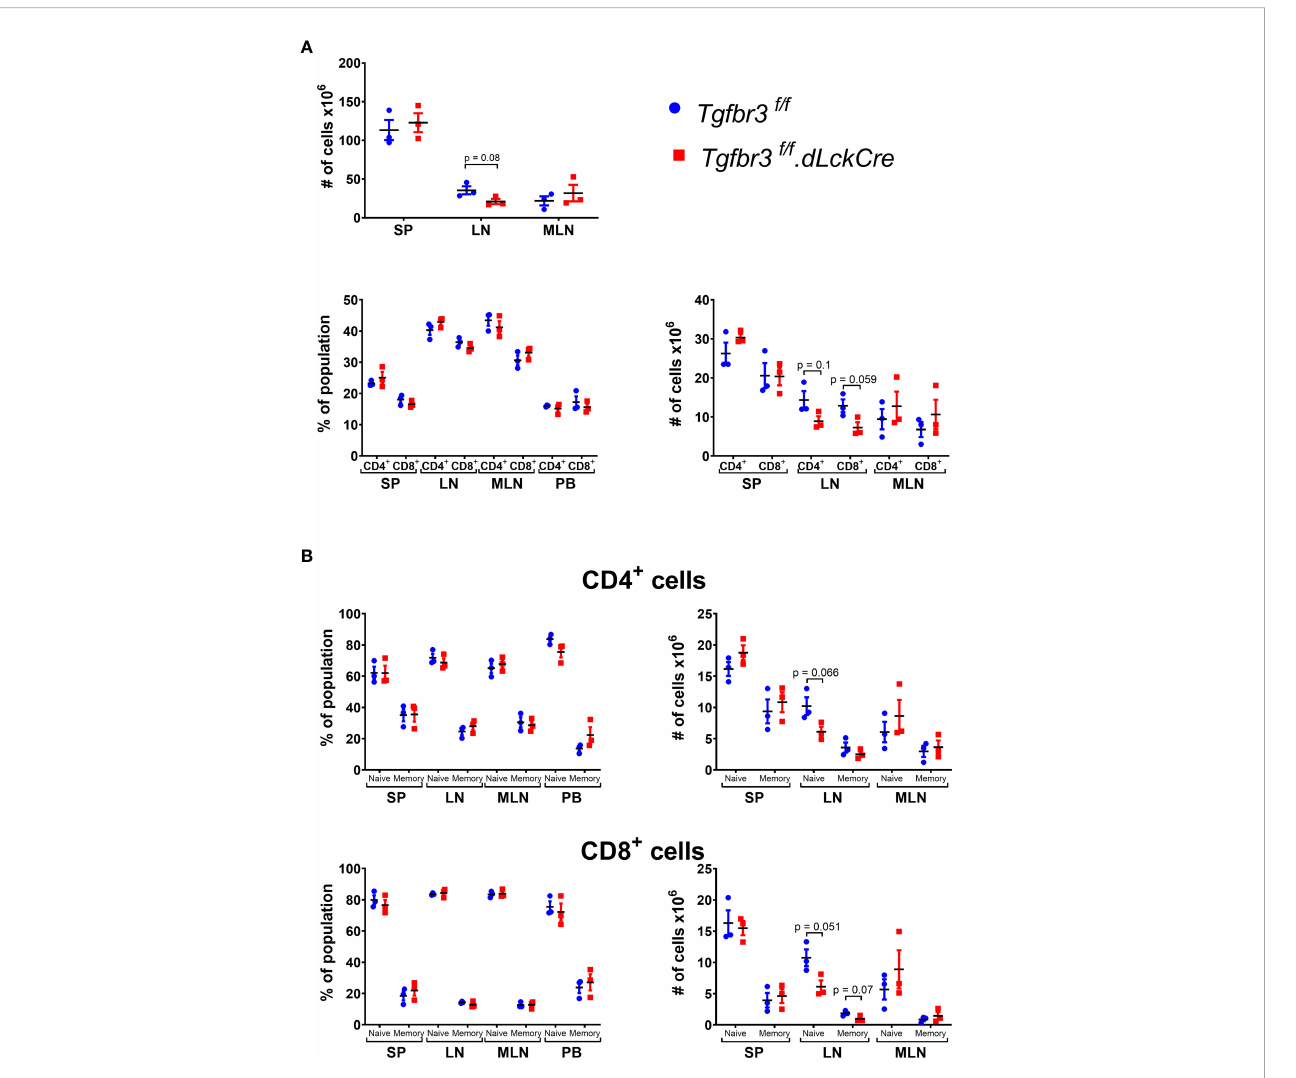
FIGURE 2 Evaluation of lymphocyte populations in Tgfbr3 fl / fl .dLckCre mice at homeostasis. (A) Scatter plots show the of total number of cells in spleen (SP), peripheral lymph nodes (LN) and mesenteric lymph nodes (MLN) from Tgfbr3 fl / fl .dLcKCre (red) and Tgfbr3 fl / fl (blue) (upper graphs) and the percentages and absolute numbers of CD4 + and CD8 + populations in the secondary lymphoid organs and peripheral blood from (bottom graphs) of the same mouse strains. (B) Percentage of naïve (CD62Lhi/CD44lo) or memory population (CD62L-/CD44hi) from CD4 + and CD8 + T cells in spleen (SP), peripheral lymph nodes (LN) mesenteric lymph nodes (MLN) and peripheral blood from Tgfbr3 fl / fl dLcKCre (red) and Tgfbr3 fl / fl (blue) control mice. Bar graphs show mean ± SEM. *p ≤ 0.05, **p ≤ 0.01, ***p ≤ 0.001. n = 3-4 mice, from 3 independent